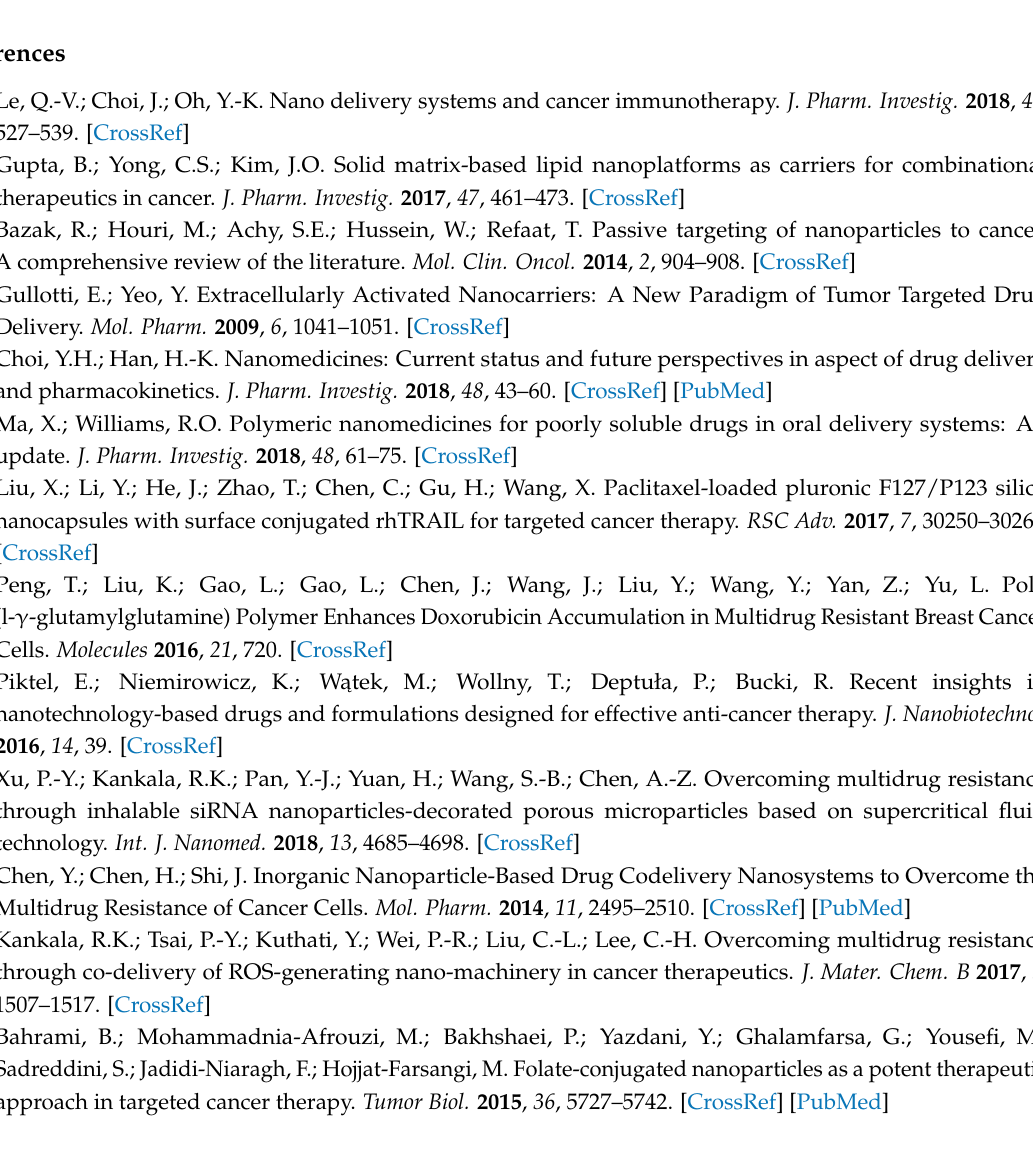
of MDA-MB-231 and MDA-MB-231(R), (B) different proteins level (P-gp and P53) of MDA-MB-231 and MDA-MB-231(R), and (C) cellular uptake of Dox and Dox/F127&P123-T f in MDA-MB-231 and MDA-MB-231(R). Figure S2. (A) FTIR spectrum and (B) 1 H NMR analysis of carboxylated poloxamer F127. Figure S3. Comparison of time-dependent and concentration-dependent cellular uptake efficiency of Dox/F127&P123 in OVCAR-3, MDA-MB-231, and MDA-MB-231. Figure S4. Standard curve for calculation of IC 50 value of Dox and Dox/F127&P123-T f . Figure S5. Quantitative evaluation of comparison of cell cycle distribution of Dox, Dox/F127&P123 and Dox, Dox/F127&P123-T f in OVCAR-3, MDA-MB231, and MDA-MB231(R). Figure S6. Quantitative evaluation of protein expression of (i) Cleaved-caspase 8, (ii) Cleaved-caspase 3, (iii) P27, (iv) P53, (v) BAX, and (vi) Bcl2 of P53 in OVCAR-3, MDA-MB231, and MDA-MB231 following treatment with Dox, Dox/F127&P123 and Dox, Dox/F127&P123-T f . Table S1. IC 50 values of Dox and Dox/F127&P123 in three cell